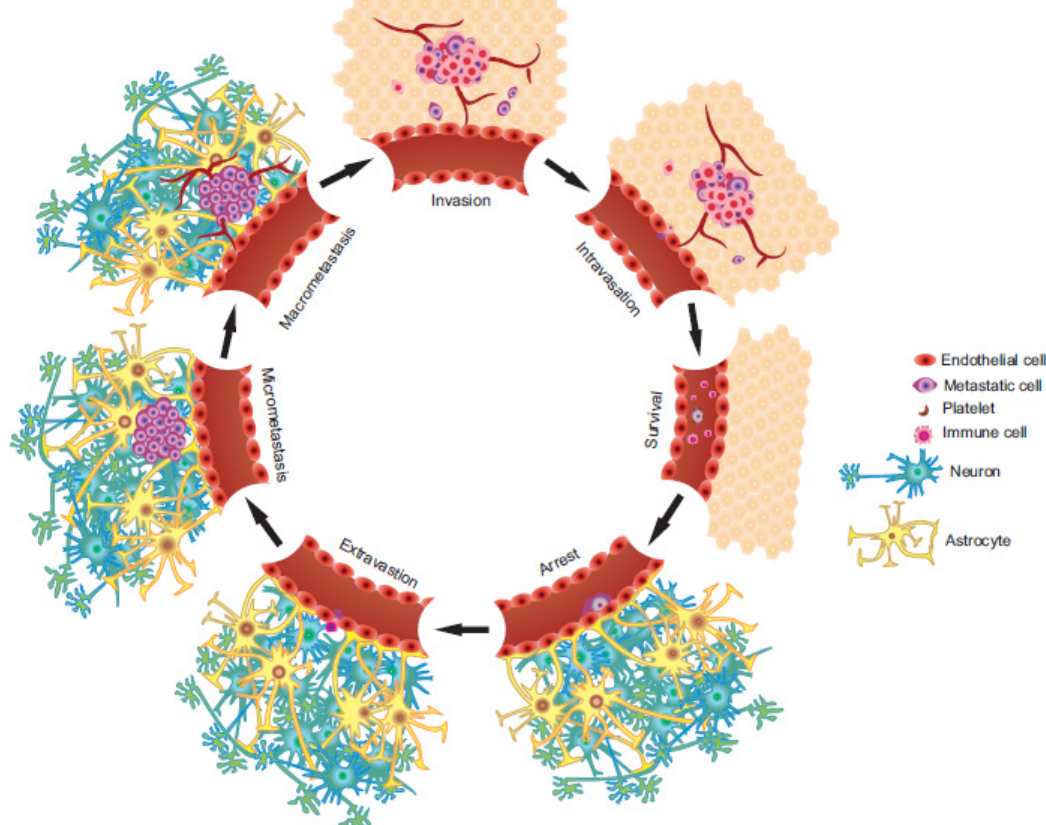
Figure 1. Stages of brain metastasis (BM). The general stages involved in the metastatic